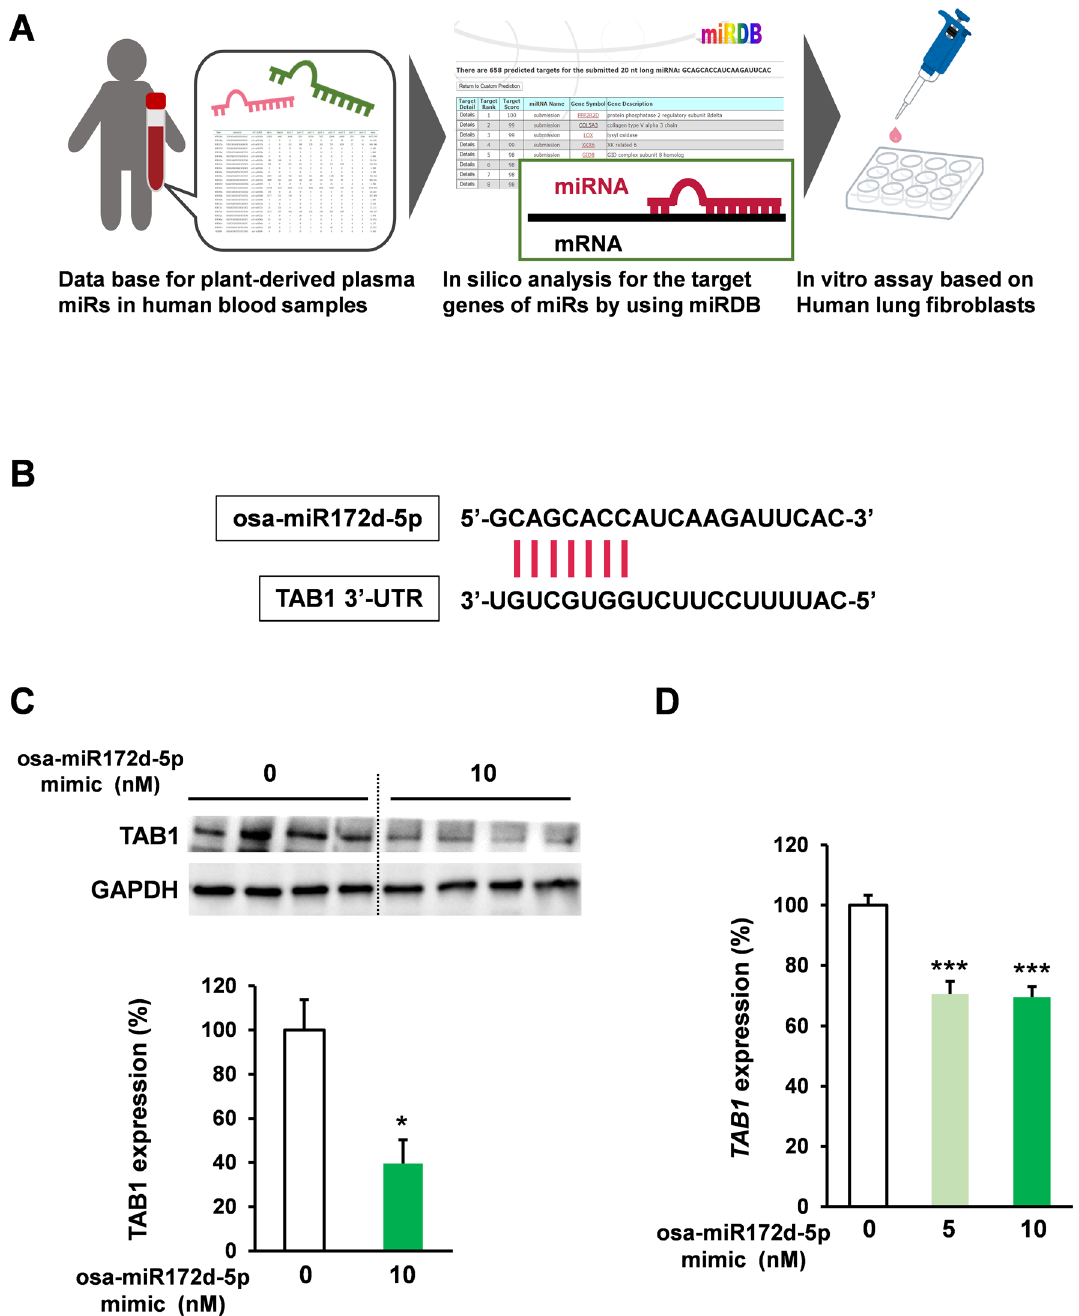
Figure 1. Osa-miR172d-5p identified as a plant miR candidate with an anti-fibrotic effect. ( A ) Scheme of plant miR selection. ( B ) In silico analysis of the interaction between osa-miR172d-5p and TAB1. ( C ) Human lung fibroblast HFL1 cells were transfected with the osa-miR172d-5p for 48 h, and TAB1 expression was evaluated via western blot analysis ( n = 4). ( D ) HFL1 cells were transfected with the indicated concentration of osa- miR172d-5p for 48 h, and cDNA was evaluated via qRT-PCR ( n = 4). Data are shown as mean ± SEM. * P < 0.05. *** P < 0.001 versus control revealed that bleomycin administration significantly induced fibrosis in the lung tissues of the negative-control mimic-treated mice. However, the fibrotic effect was attenuated by osa-miR172d-5p treatment compared with that by the negative control mimic (Fig. 4B,C). Collagen accumulation is the characteristic change in idiopathic pulmonary fibrosis 38 . Excessive extracel- lular matrix accumulation compromised the respiratory function caused by the reduction of lung compliance 38 . Immunofluorescence analysis of the lung section demonstrated that bleomycin treatment induced the collagen 1-positive area, and bleomycin-induced increase in collagen 1 was significantly suppressed by osa-miR172d-5p